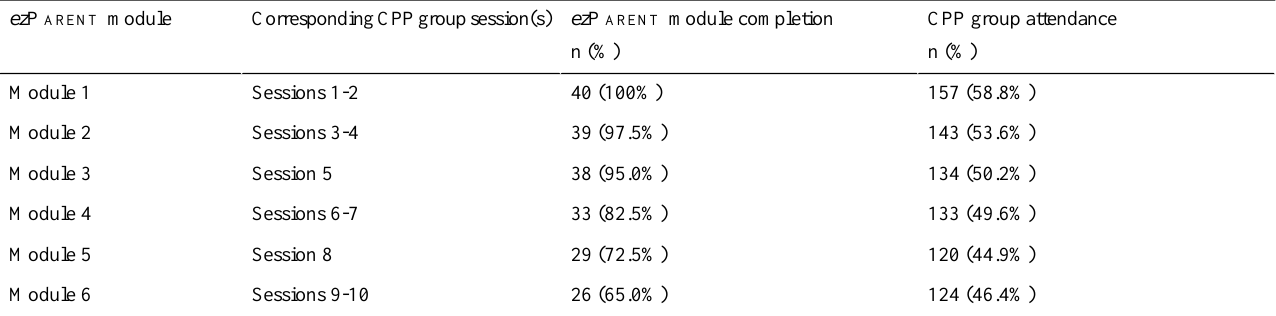
Table 2. ez P ARENT module (n=40) and CPP group-base (n=267)